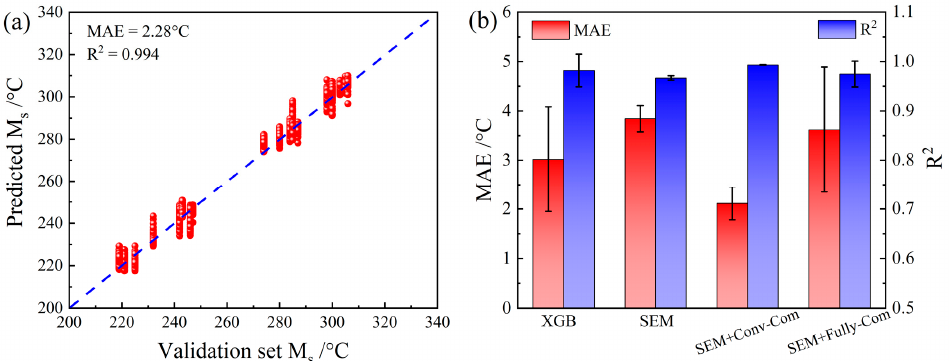
Figure 10. Results of the CNN model after addition of microstructure information from the fully connected layer: ( a ) results of the validation set and ( b ) comparison of MAEs and R 2 values.